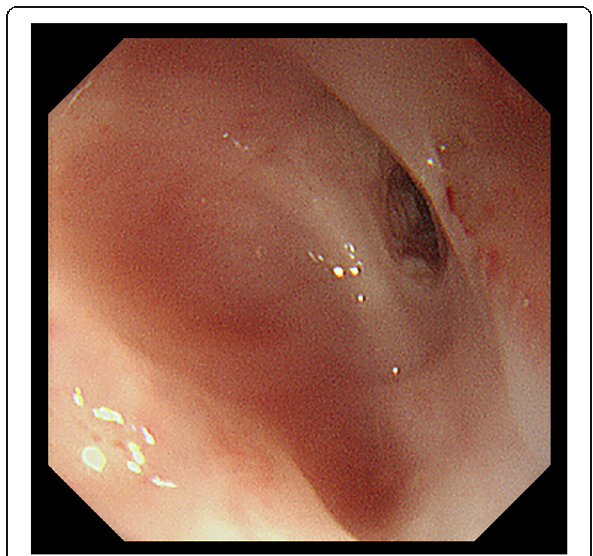
Fig. 5 Endoscopic finding of 7 months after the initial operation. The stricture of the residual cervical esophagus